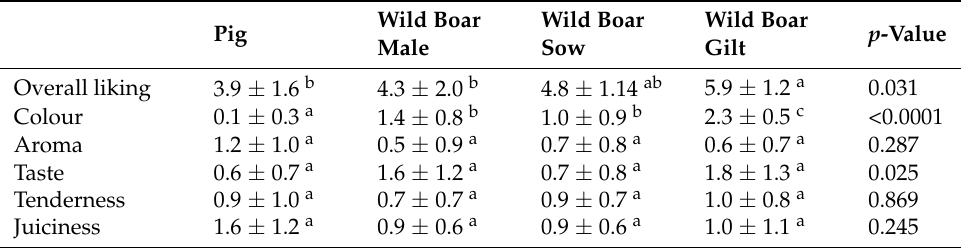
Table 3. Sensory results from pig meat and different types of wild boar meat by untrained panelists ( n =